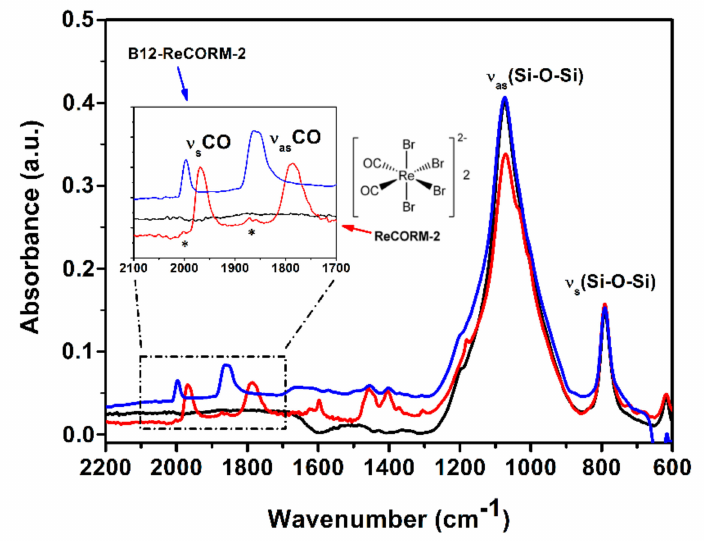
Figure 2. Solid-state IR spectra (2200–600 cm − 1 range) of untreated Coscinodiscus frustules (CF, black), ReCORM-2 (CF-1, red trace) and B 12 -ReCORM-2 (CF-12, blue trace) treated Coscinodiscus frustules. Insert shows magnified 2100–1700 cm − 1 region. Asterisks (*) in the insert indicate hydrated silicon dioxide Si-O-Si overtone modes; ν s CO and ν as CO indicate respectively the symmetric and asymmetric stretching Re-CO bands of the